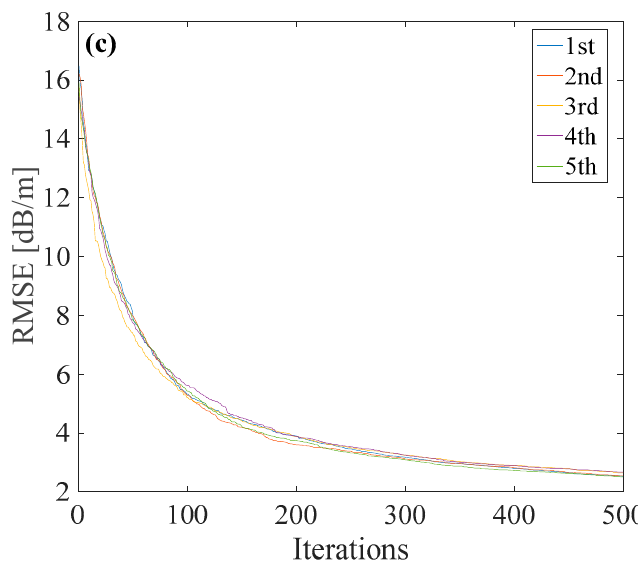
Figure 11. The RMSE between the computed and the picked attenuation coefficient for the three algorithms after 500 generations of evolution. ( a ) RMSE from the SGA; ( b ) RMSE from the AMPGA; ( c ) RMSE from the AMPGA with constraints.